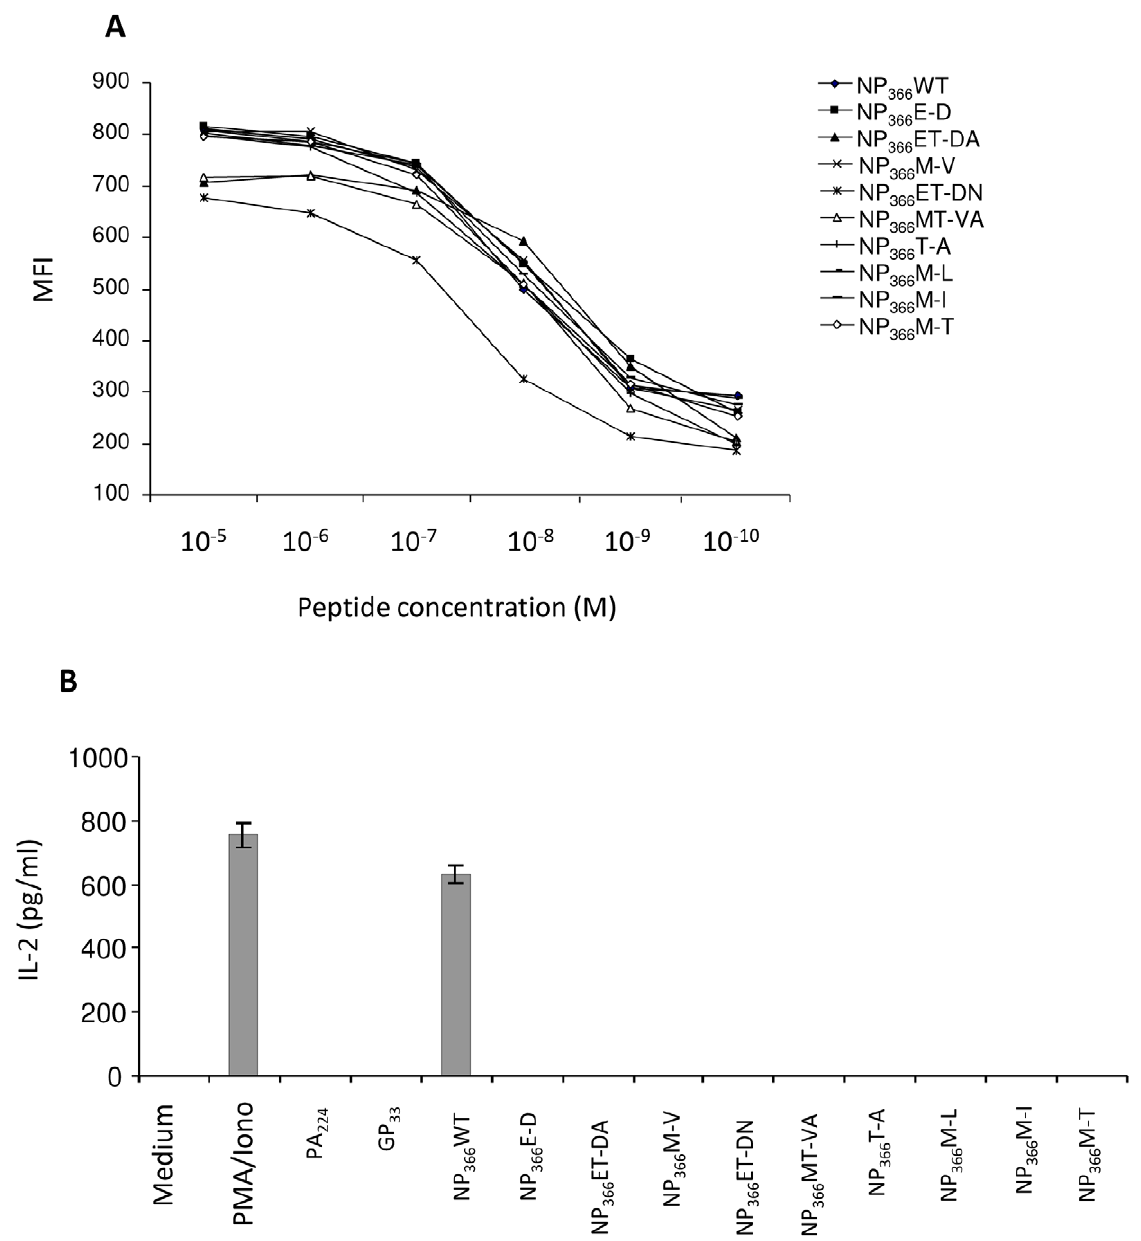
Figure 5. Plasticity of a dominant public TCR to NP 366 /D b variants. Serially titrated amount of synthetic NP 366 /D b peptides identified in table 1 were used to stabilize D b expression on the surface of a TAP-deficient RMA-S cells in an RMA-S assay (A). The results were expressed as mean fluorescence intensity (MFI). The ability of the NP 366 /D b variants to trigger activation of a T cell transfectant (clone A3-4) expressing the dominant public TCR specific for the PR8-NP 366 /D b ligand, was assessed by an IL-2 assay (B). The data are representative of two independent